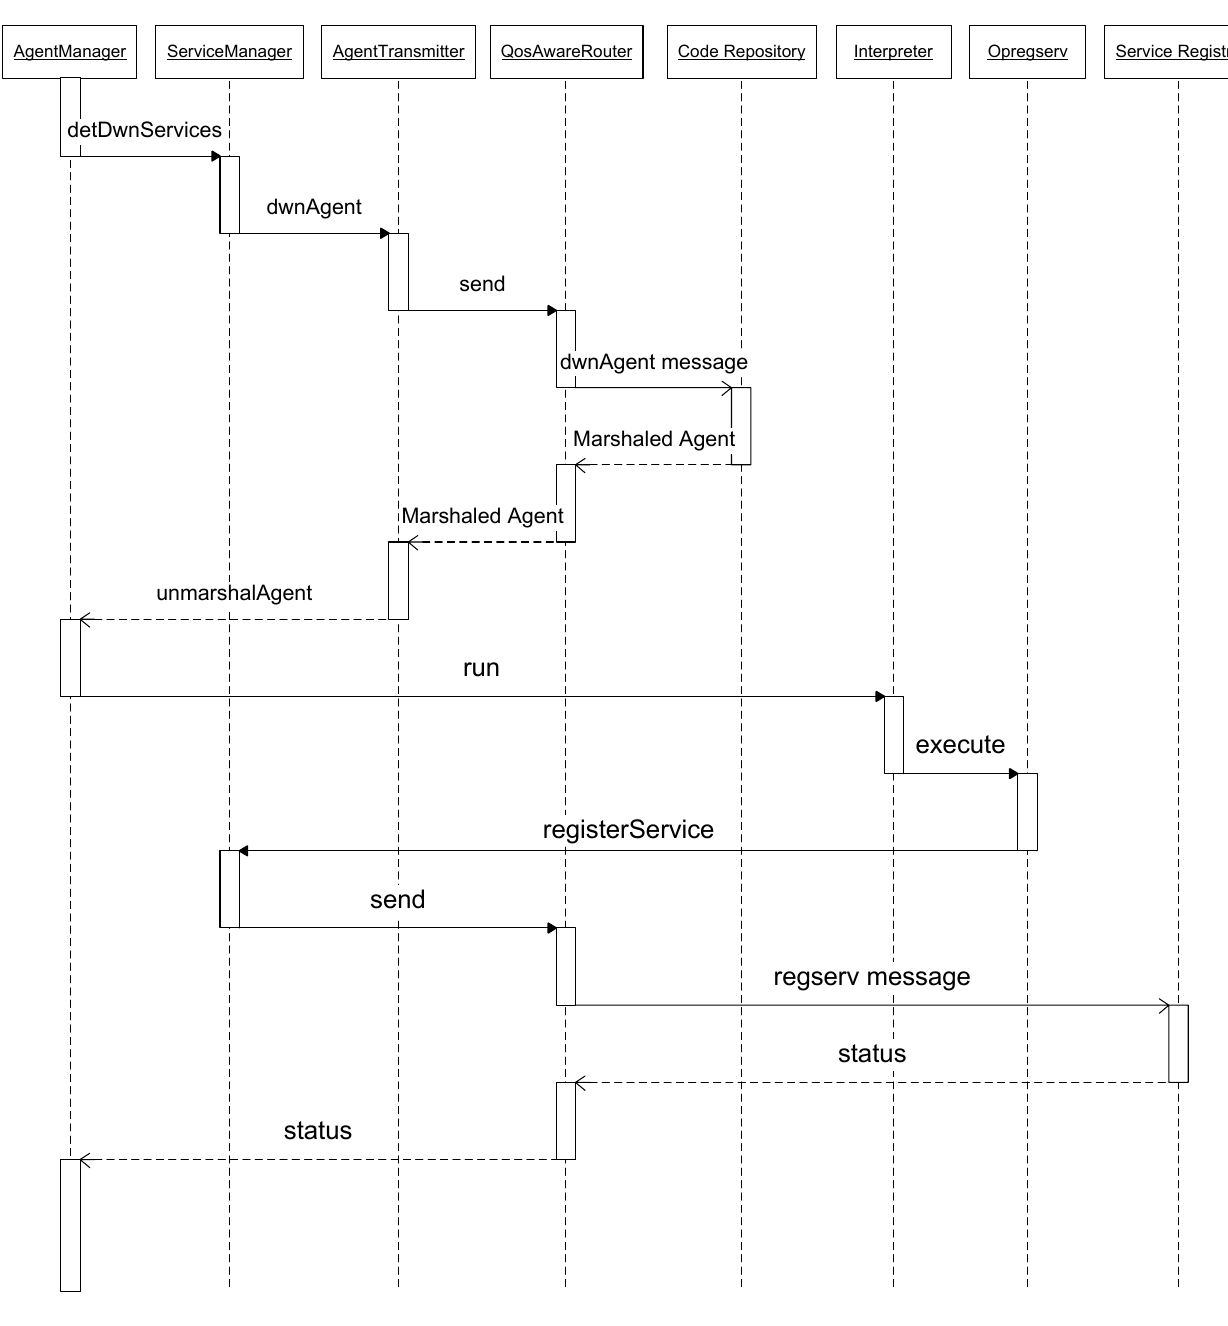
Figure 10. Sequence diagram for the startup process of a